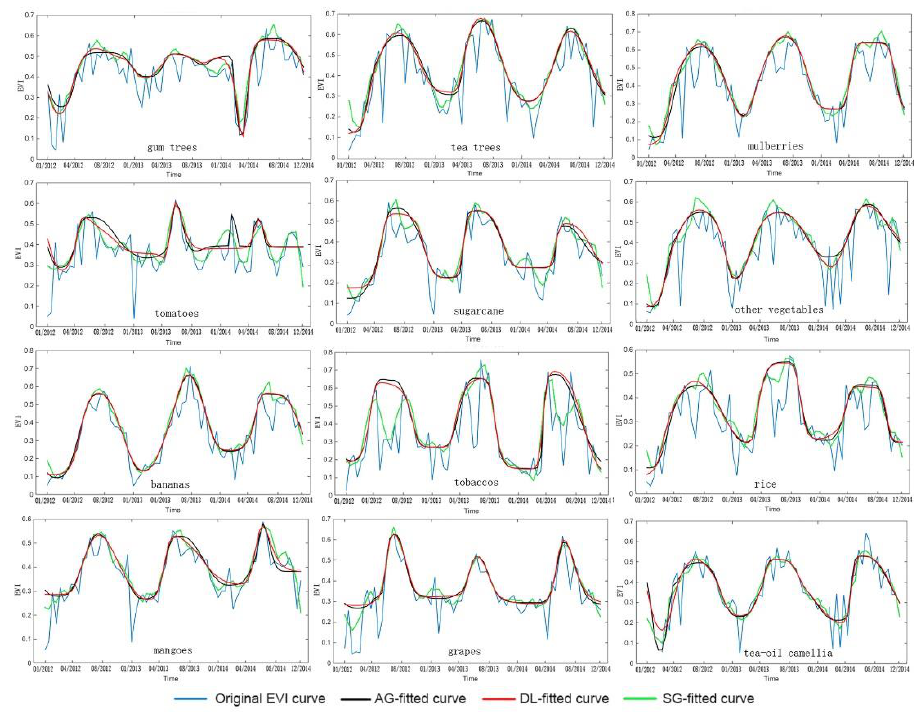
Figure 2. MODIS EVI time series, and fitted curves using the Savitzky–Golay filter (SG), asymmetric Gaussian (AG), and double logistic function (DL).